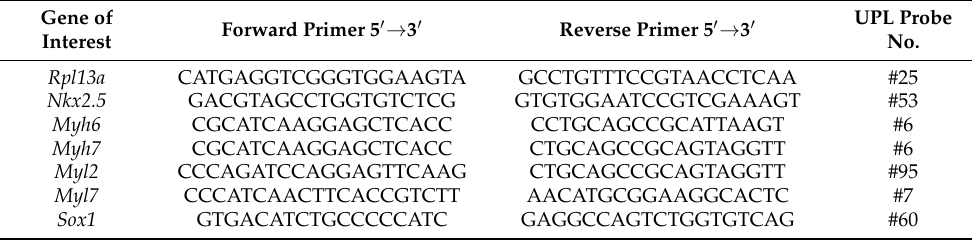
Table 1. Sequence of primers used in quantitative